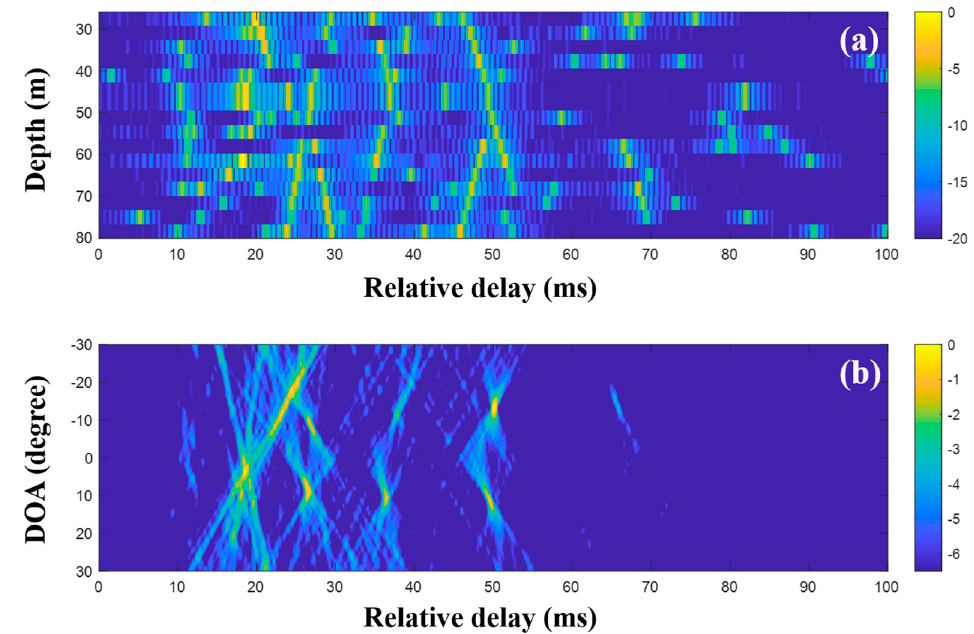
Figure 4. Direction-of-arrival (DOA) estimation using compressive sensing (CS) with a single measurement. The signal-to-noise ratio (SNR) is − 9.8 dB: ( a ) arrival structures via sequential CS usage with the signals at the vertical line array (VLA) and ( b ) DOAs using delay-and-sum beamforming with the arrival structures.